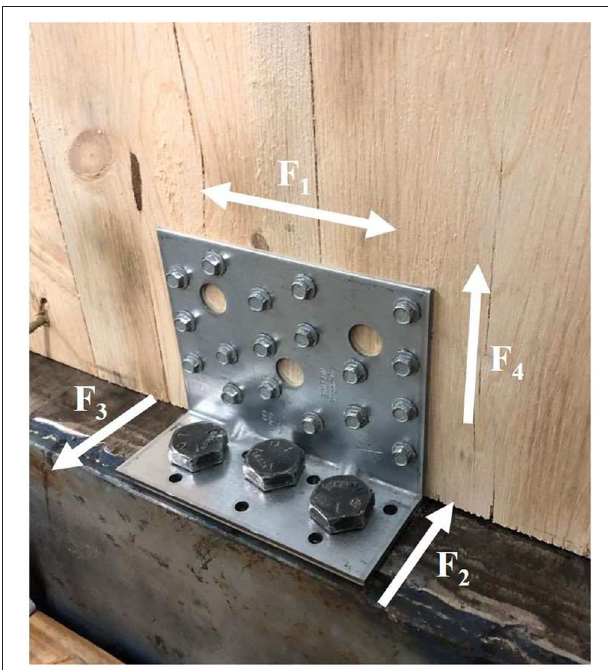
FIGURE 3 | Representation of bracket-type connections used in simulations.